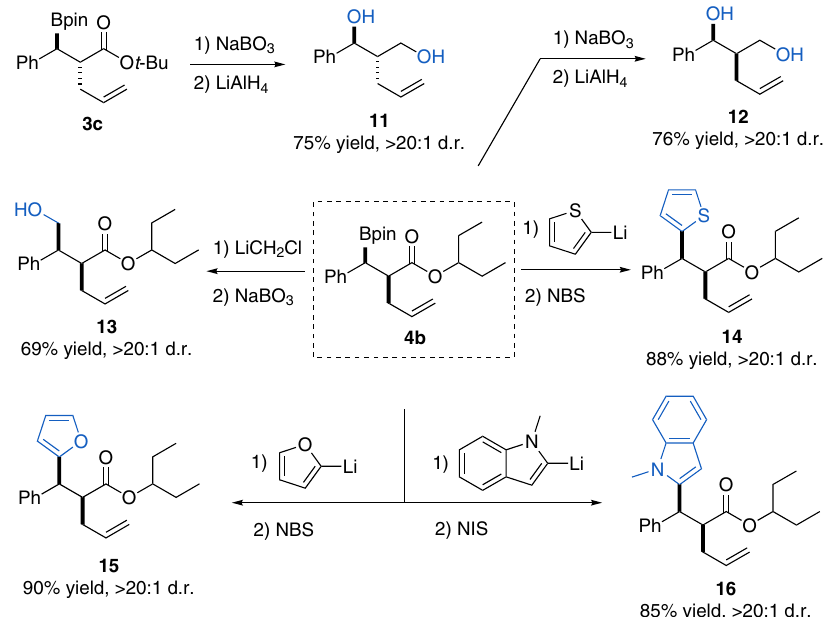
Fig. 6 Products Transformations. Transformations of the boronic ester to alcohols ( 11 and 12 ), hydroxymethyl ( 13 ), and heterocycles ( 14 , 15, and 16 ).